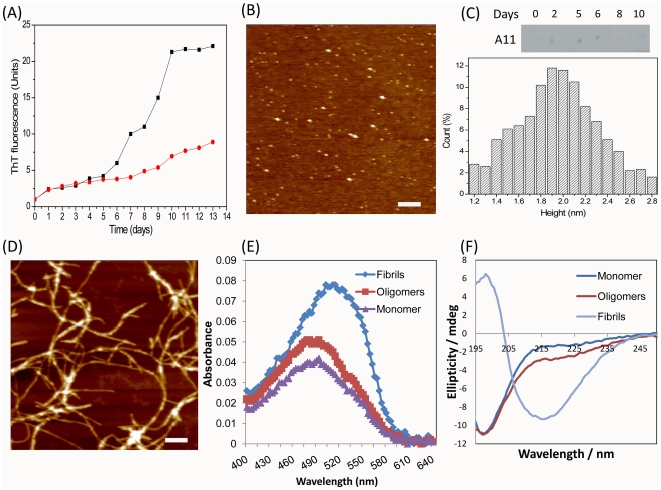
Amyloid properties of α-synuclein.(A) Kinetics of amyloid formation monitored by thoflavin T fluorescence at α-synuclein concentrations of 0.71 mM (black squares and line) and 0.21 mM (red circles and line). (B) AFM images of α-synuclein oligomers. (C) Top: dot blot analysis of interactions of anti-oligomeric A11 antibodies with the amyloid containing aliquots; days of amyloid incubation are indicated. Bottom: the distributions of the z-heights of α-synuclein oligomers measured by AFM cross-section analysis. (D) AFM images of α-synuclein fibrils. Scale bars in x,y-plain equal to 500 nm (B,D). (E) Congo red binding to α-synuclein monomeric, oligomeric and fibrillar species as denoted by corresponding color coding. (F) CD spectra of monomeric, oligomeric and fibrillar α-synuclein as denoted by corresponding color coding.